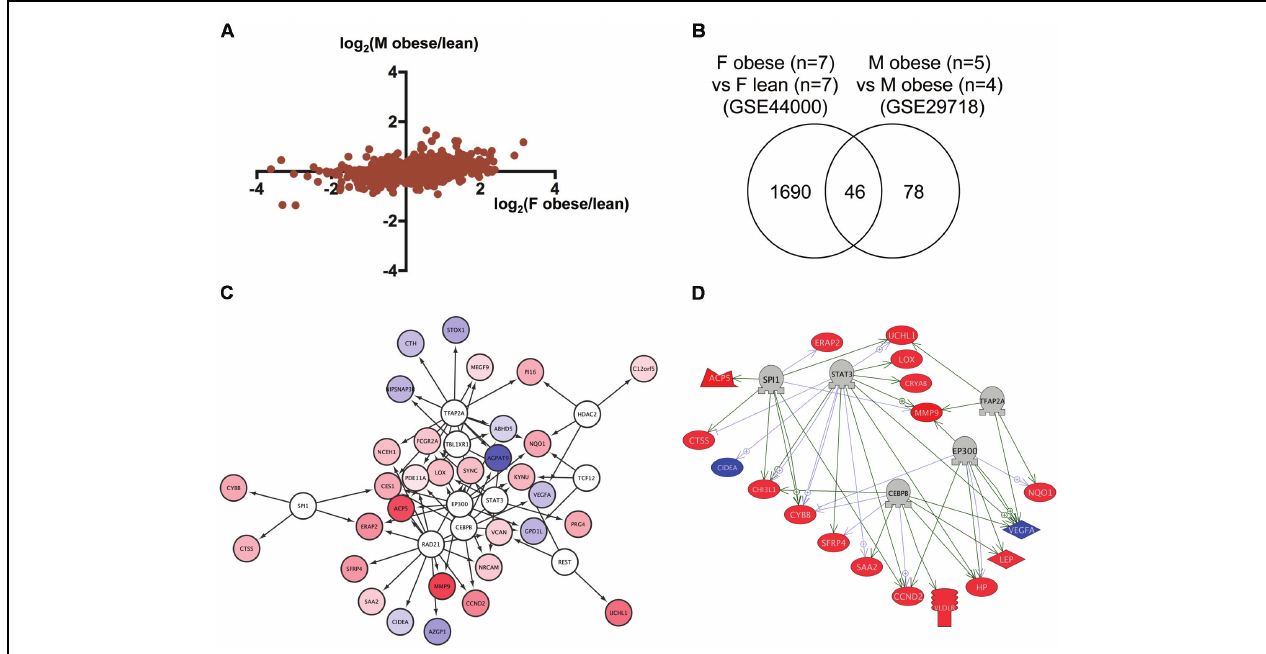
FIGURE 4 | Identification of the regulatory network for genes dysregulated in obese humans. (A) Correlation of genes dysregulated in adipose tissues from female and male obese humans. (B) Venn diagram of the numbers of DEG in obese females and males. (C) A regulatory network identified by iRegulon for the 46 common genes between obese females and males. Genes shown in blue and red indicate decreased and increased expression, respectively, by obesity. (D) A regulatory network identified by Pathway Studio for five regulators and their 18 target genes. Genes shown in blue and red indicate decreased and increased expression, respectively, by